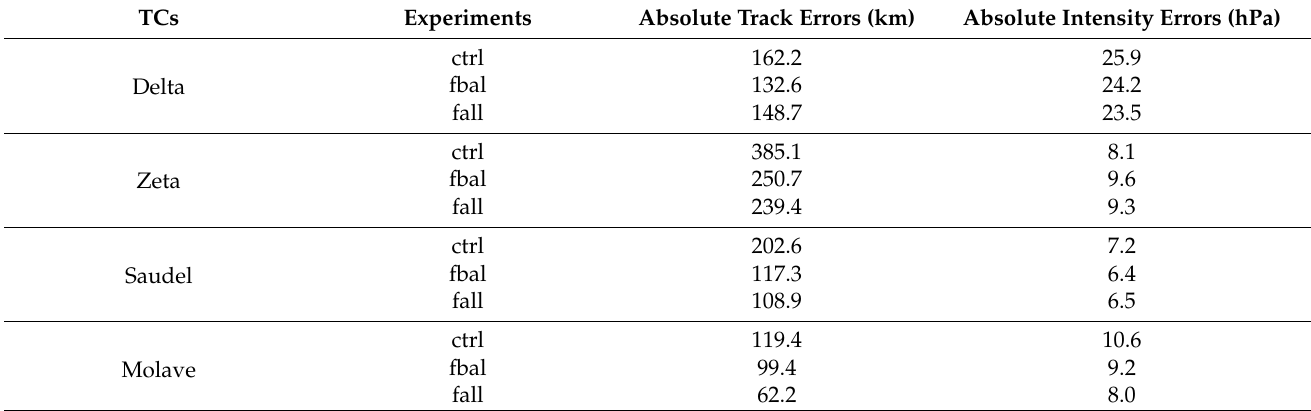
Table 2. Track and intensity errors average for each TC. Intensity errors are based on the minimum mean sea level pressure (MSLP). Absolute errors are the absolute value of